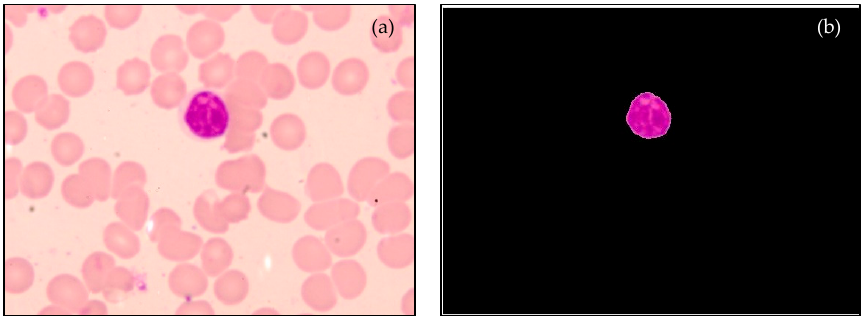
Figure 8. Sample results of segmentation process: ( a ) Normal lymphocyte, and ( b ) Segmented nucleus.